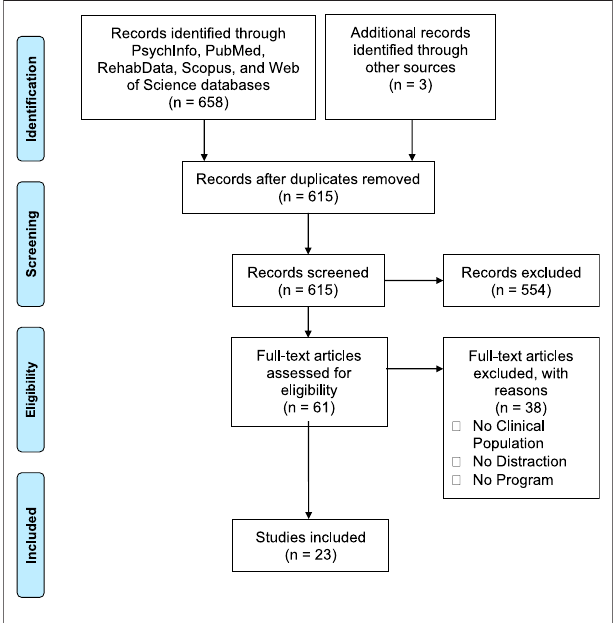
FIGURE 1 | PRISMA fl owchart of article